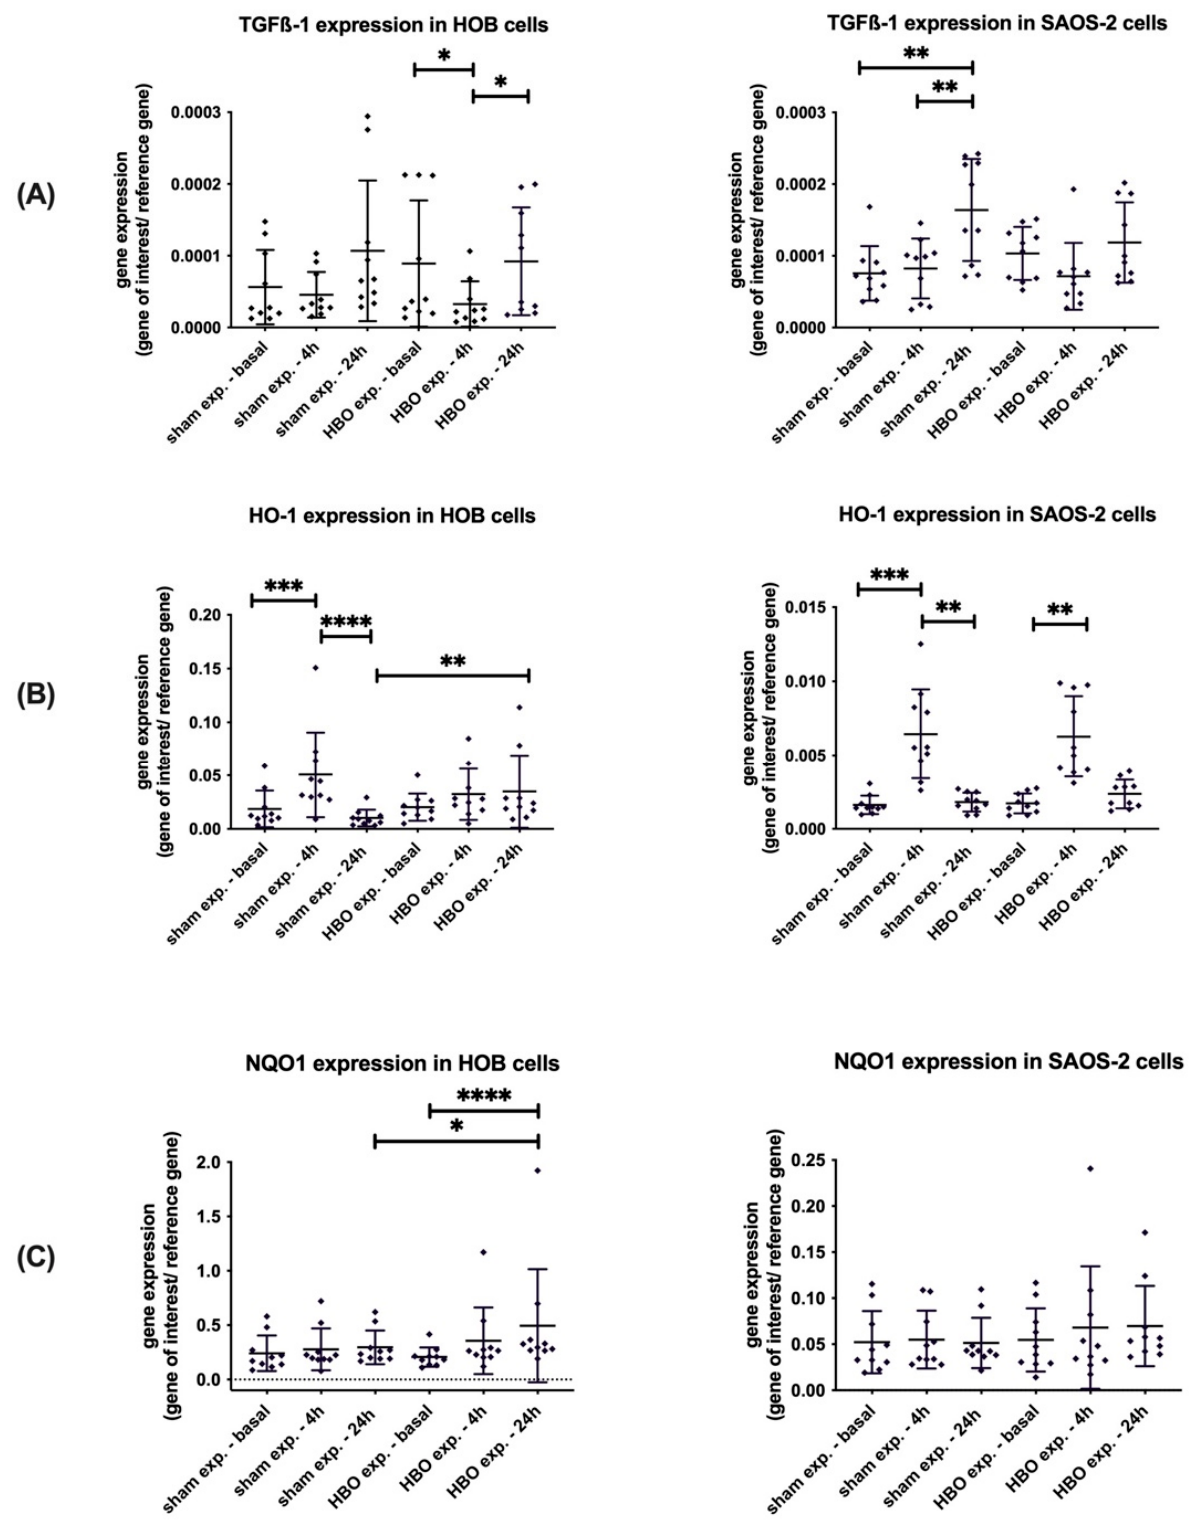
Figure 4. Gene expression of TGFß-1 ( A ), HO-1 ( B ), and NQO1 ( C ) in HOB and SAOS-2 cells after exposure to hyperbaric oxygen (HBO exposure) and ambient air (sham exposure). Data are presented as mean ± SD; p -values: * p < 0.05, ** p < 0.01, *** p < 0.001, **** p < 0.0001.